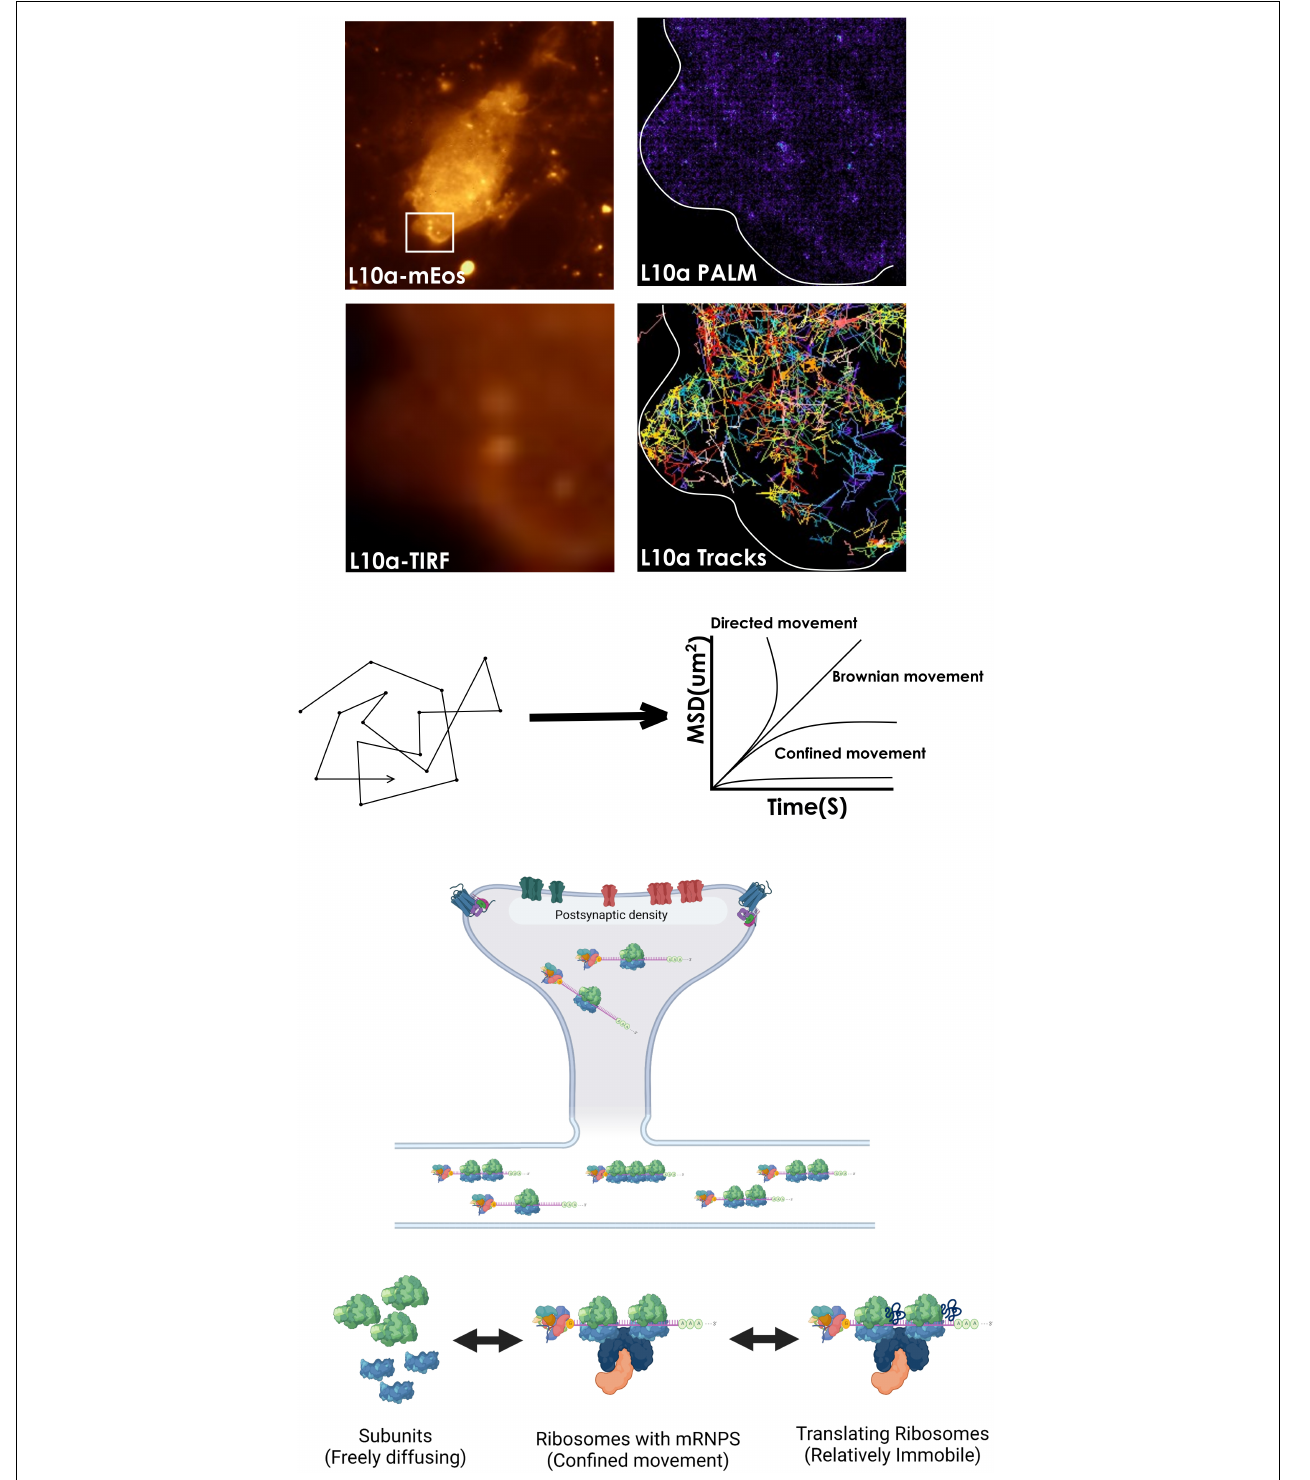
FIGURE 3 | Tracking ribosomal mobility for locating “hotspots” of active translation. Visualizing and tracking ribosomal subunits at the single-particle level is possible by tagging a subunit protein such as L10a with photoactivable fluorescent proteins such as mEos within a cell. Analysis of their mean square displacement (MSD) trajectories of single protein molecules can then be used to calculate the diffusion coefficients of various ribosomal populations, that switch between diffusional states while functioning within cells. In addition, perturbations with pharmacological agents that destabilize ribosomes can confirm their engagement in active translation. Also, an HMM-based analysis of the trajectories can be used to reveal the mechanisms underpinning the conversion between diffusional states of ribosomes (not shown).